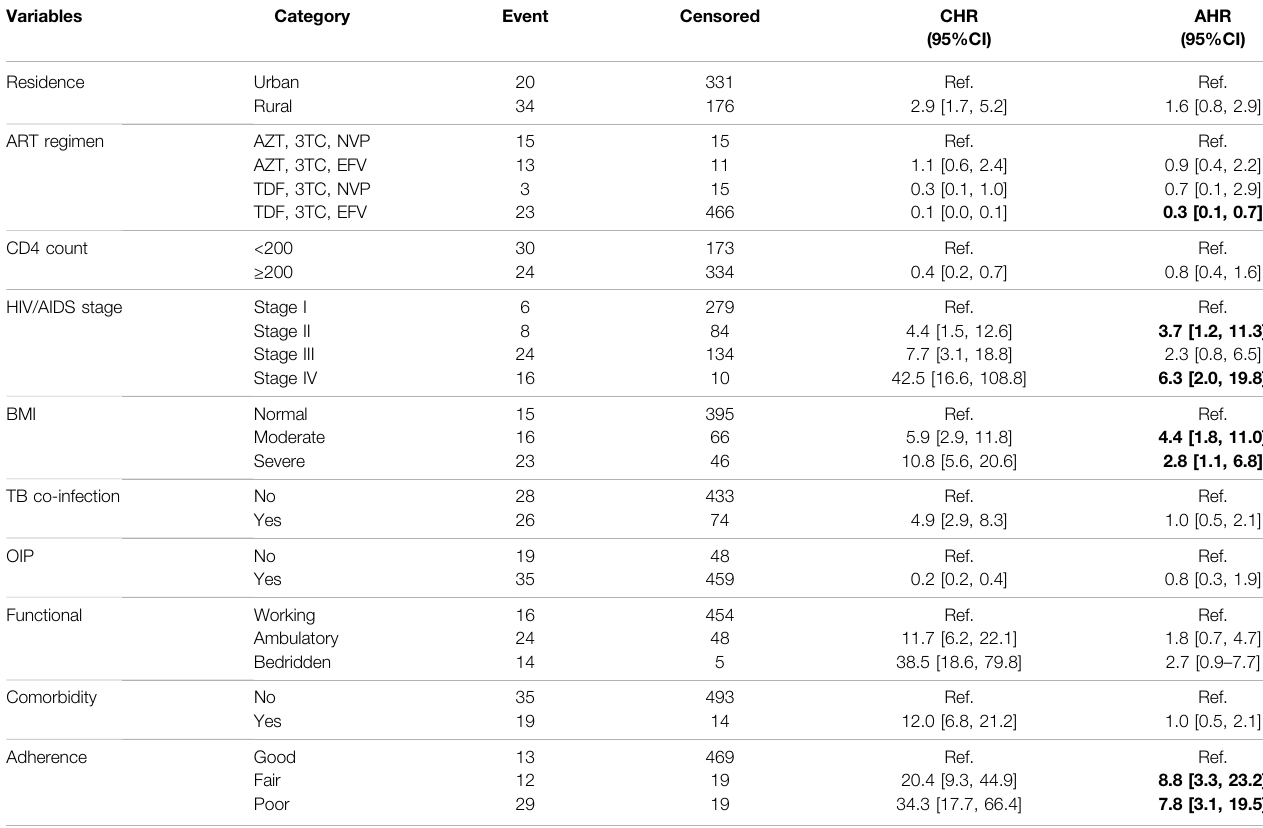
TABLE 3 | Predictors of the time to ART ADR among HIV/AIDS patients on ART at public hospitals in Eastern Ethiopia, 2013 –